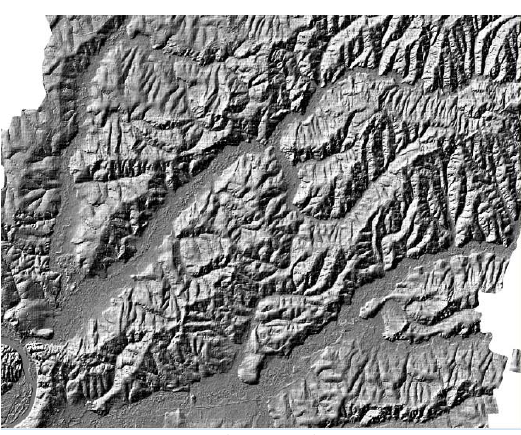
Figure 1. The results of the relief shading construction